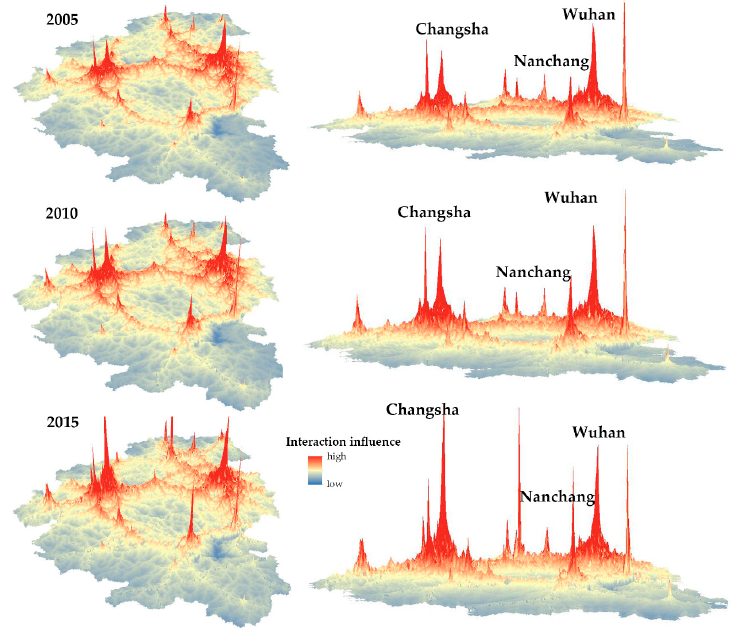
Figure 4. Interaction influence in the urban agglomeration in the middle reaches of the Yangtze river in China.